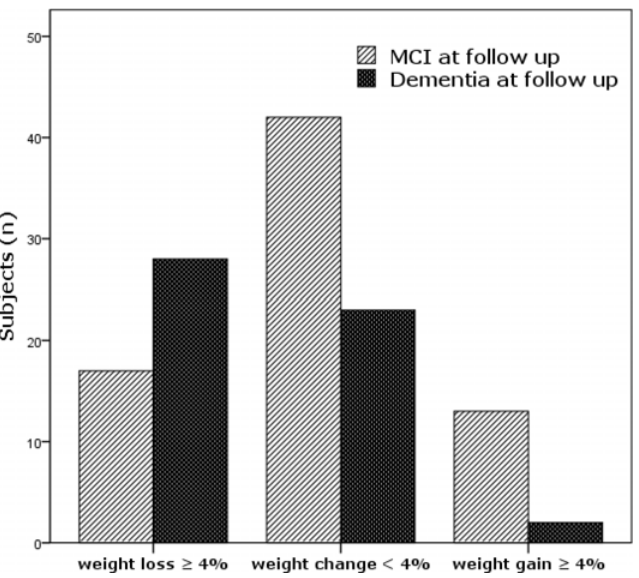
Fig 1. Progression to dementia of MCI subjects divided into three categories of weight